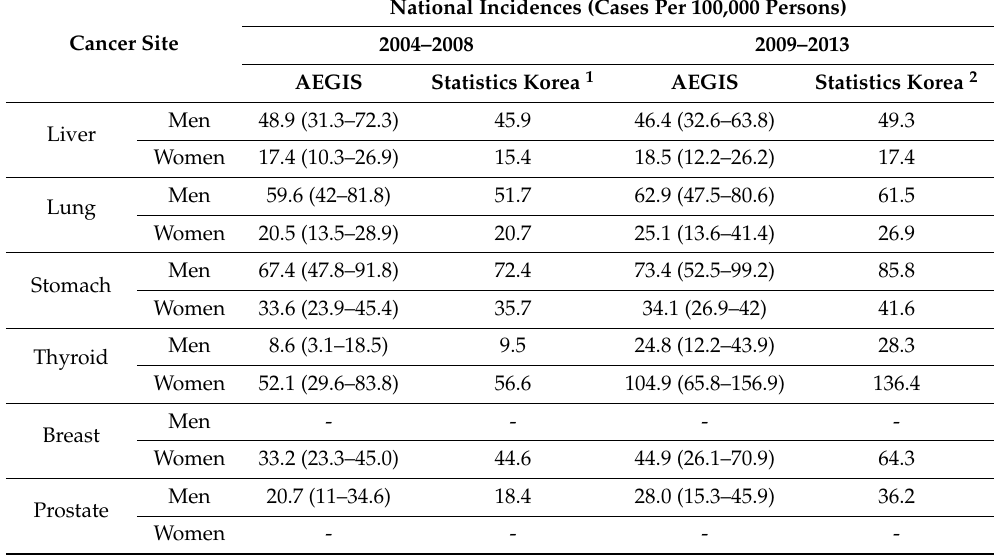
Figure 3. Disease mapping for regional differences in the incidence of liver cancer (women) in South Korea and the United States from 2009 to 2013 (age adjusted).